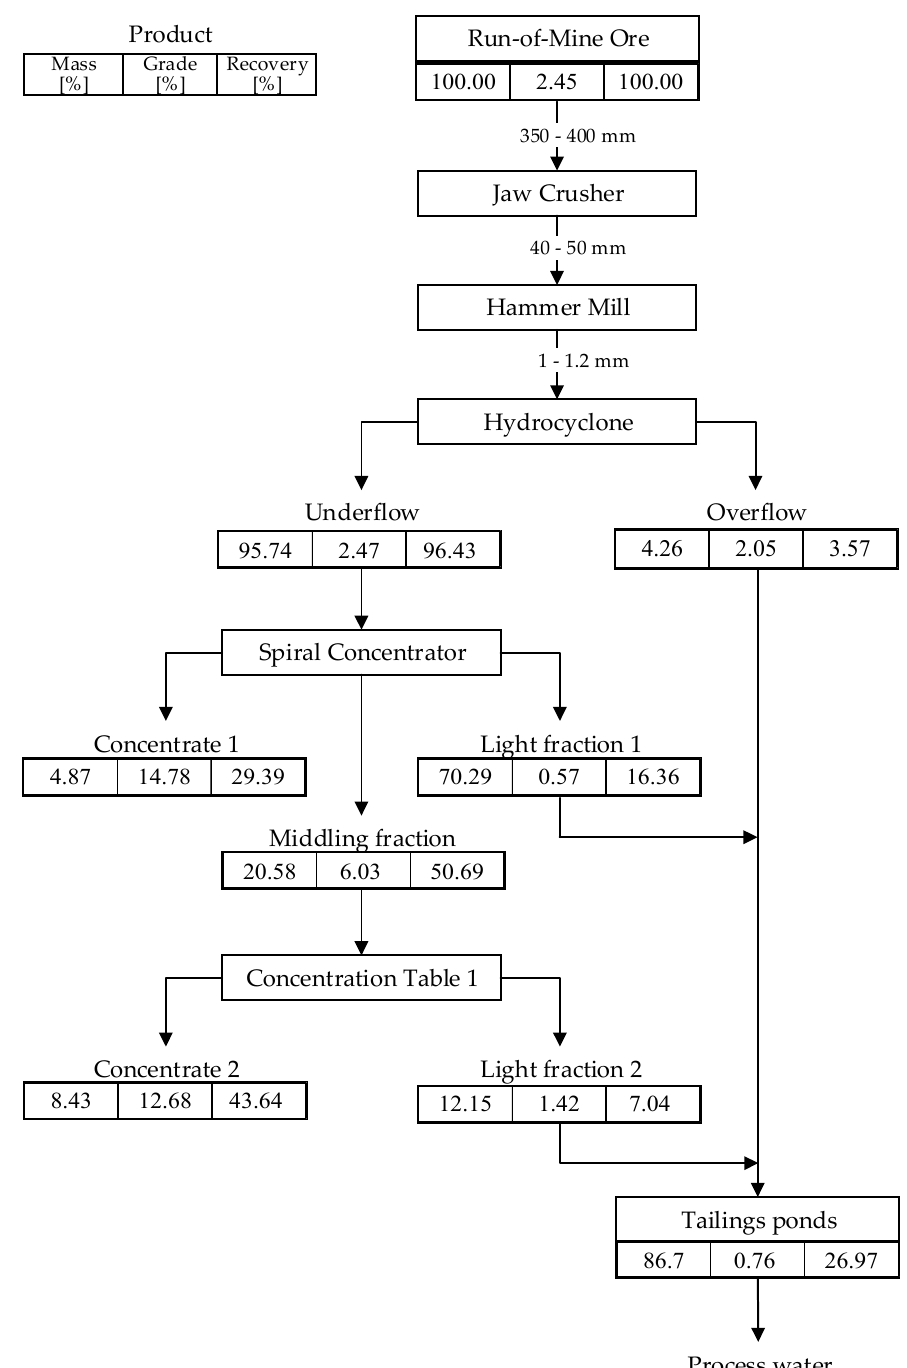
Figure 6. Mass and metallurgical balances of flowsheet of the small-scale processing plant for the recovery of lead vanadate minerals.